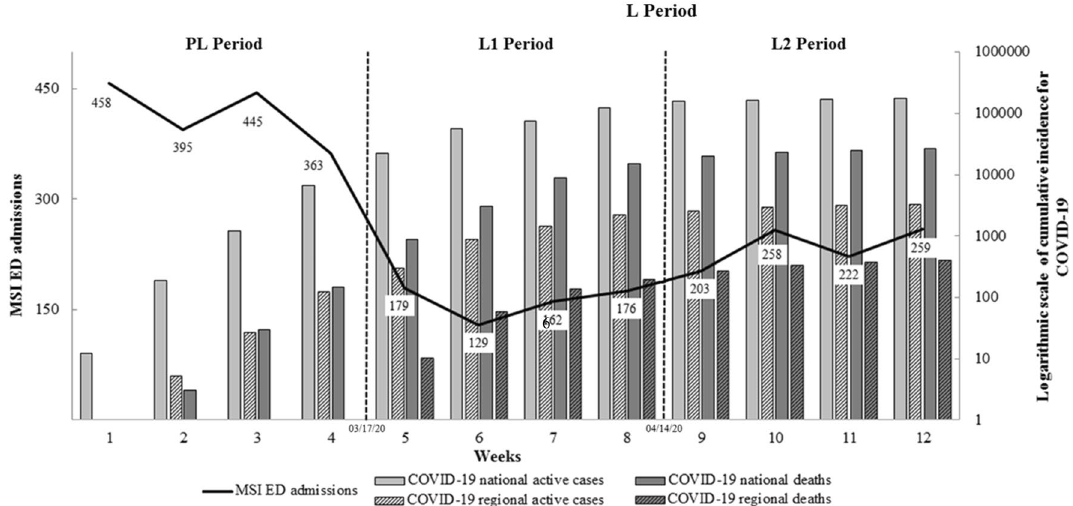
Figure 1. Change in the weekly admissions for MSI in the ED at Nantes University Hospital (linear scale graph), and the weekly cumulative incidence of COVID-19 national and regional active cases and deaths (logarithmic scale bar graphs) between the PL and L periods The first vertical line refers to the national French lockdown on the 17th of March 2020. The second vertical line refers to the virtual break separating L1 (Early lockdown period) and L2 (Late lockdown period) on the 14th of April 2020. MSI: Musculoskeletal injury, ED: Emergency department, PL: Pre-lockdown (from 02/18/20 to 03/16/20), L: Lockdown (from 03/17/20 to 05/11/20), L1: Early lockdown, L2: Late